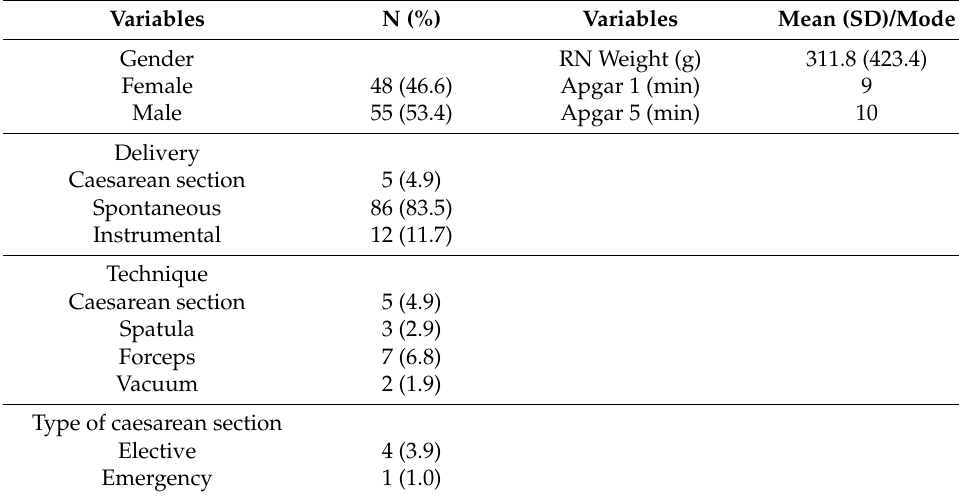
Table 4. Obstetric and perinatal variables of the